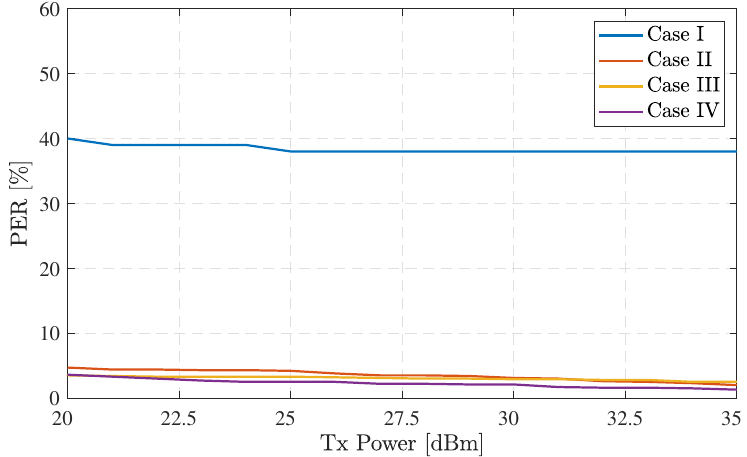
Figure 16. Illustration of the uplink PER with a different set of LoRa parameters ( SF = 12, B = 500 kHz, λ = 0.78/km 2 ) showing the feasibility of using LoRa over Satellite